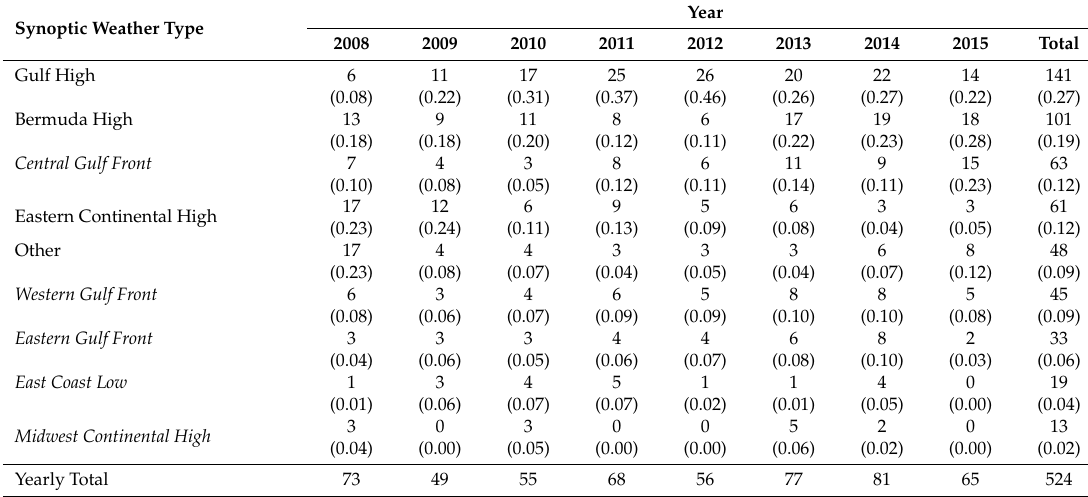
Table A3. Annual and total frequency (and proportion of the total) of the unfavorable (in italics; Western Gulf Front, Central Gulf Front, Eastern Gulf Front, East Coast Low, Midwest Continental High) and favorable (East Continental High, Bermuda High, Gulf High) synoptic weather types corresponding to all sampled calendar days (N = 524) throughout our study period (March to May 2008–2015). The synoptic weather types are listed in descending order of total